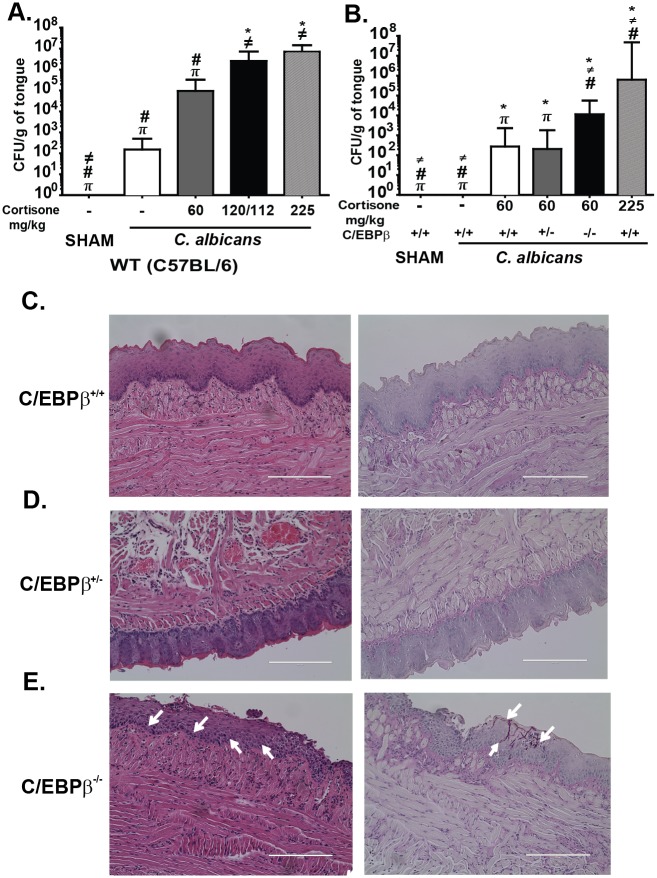
C/EBPβ-/- mice exhibit increased susceptibility to oral candidiasis in the context of cortisone-induced immunosuppression.
(A) C65BL/6 mice (“WT”) were treated with the indicated doses of cortisone acetate at days -1, +1 and +2 relative to infection. After 5 d, fungal loads in tongue were assessed by CFU enumeration of tongue tissue homogenates. SHAM (n = 3), No cortisone control (n = 5), 60mg/kg (n = 9), 120/112mg/kg (n = 8), and 225mg/kg (n = 8). Data are pooled from 2 independent experiments. Bars indicate geometric mean with 95% CI. P<0.05 by t-test with Mann-Whitney correction: * vs NO CORT, ≠ vs 60mg/kg, # vs 120/112mg/kg and π vs 225mg/kg. (B) The indicated mice were infected orally as described in panel A. Cortisone acetate was administered subcutaneously on days -1, +1 and +2 relative to infection. C/EBPβ+/+ SHAM (n = 3), C/EBPβ+/+ (n = 5), C/EBPβ+/+ 60 mg/kg (n = 16), C/EBPβ+/- 60mg/kg (n = 16), C/EBPβ-/- 60mg/kg (n = 10) and C/EBPβ+/+ 225mg/kg (n = 4). P<0.05 by t-test with Mann-Whitney correction: * vs C/EBPβ+/+ NO CORT, ≠ vs C/EBPβ+/+ 60mg/kg, # vs C/EBPβ+/- 60mg/kg and π vs C/EBPβ-/- 60mg/kg. Data are pooled from two independent experiments. C. Representative tongue sections from the indicated mice were stained with H&E or Periodic-acid Schiff (PAS). Scale bar indicates 200 μM. White arrows indicate hyphae.